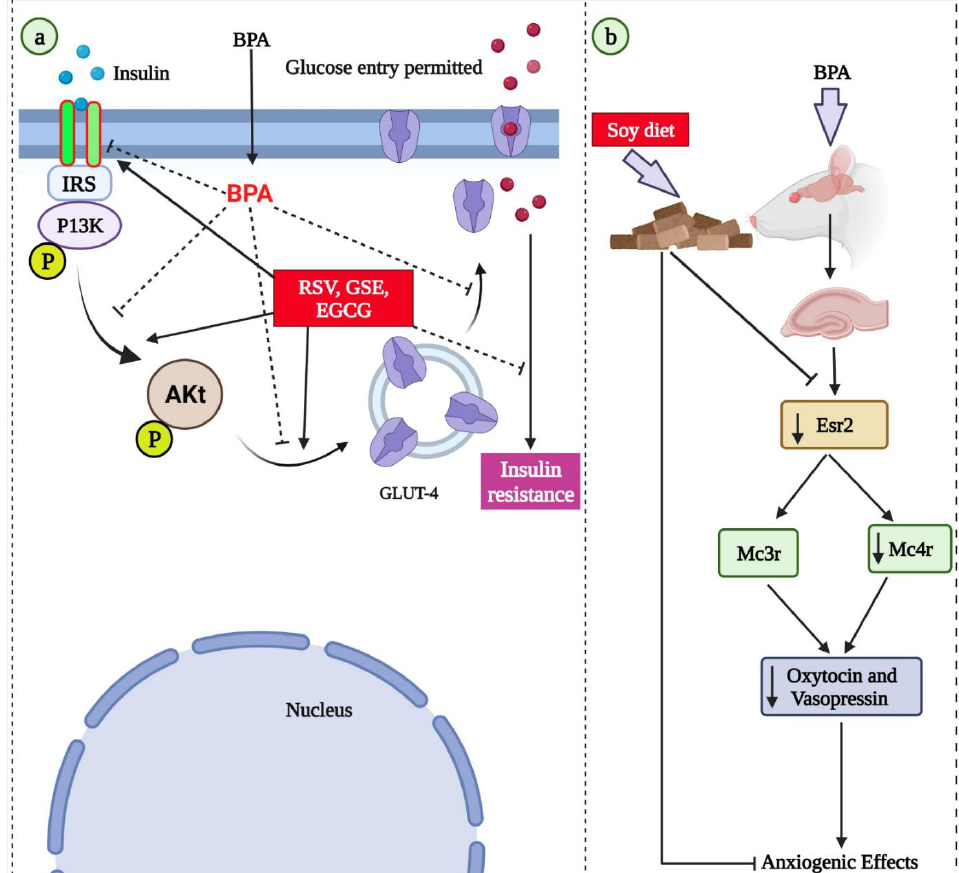
Figure 2. ( a ) The schematic representation of the insulin signaling promoting potential of resveratrol, grape seed extract [183], and epigallocatechin gallate (EGCG) [231]. ( b ) Developmental BPA exposure is associated with anxiogenic effects in juvenile rats via downregulating the expression of estrogen receptor beta (Esr2) and melanocortin receptors (Mc3r, Mc4r) in amygdala. The soy diet supplemen- tation mitigated anxiogenic effects by upregulating these genes [235]. IRS: insulin receptor substrate; PI3K: phosphatidylinositol 3-kinase; Akt: protein kinase